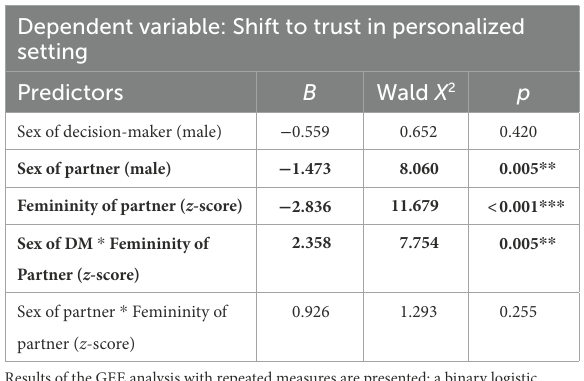
TABLE 2 Shifts in trust, degree of facial femininity, and partners’